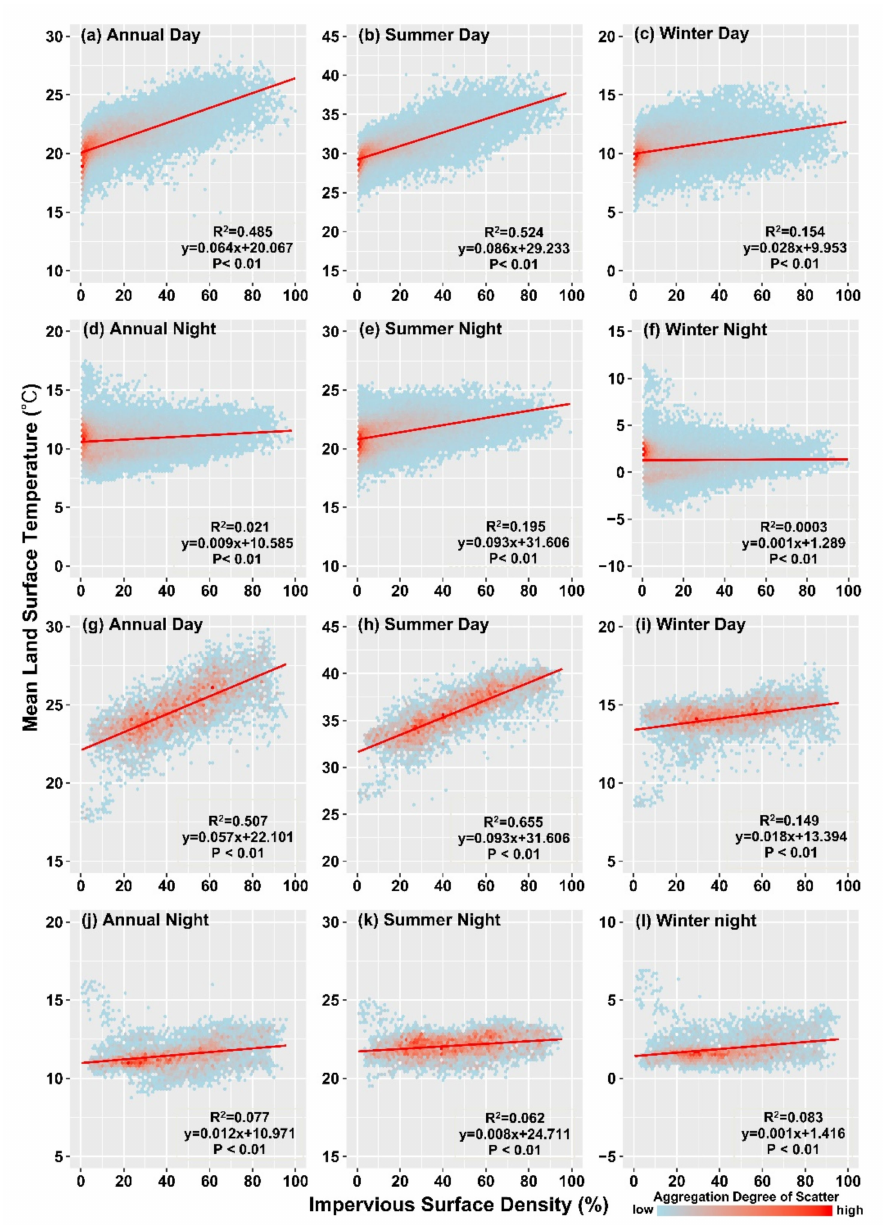
Figure 9. Relations between the density of the impervious surface area and the LST across the YRD. ( a – f ): Relations between the density of the impervious surface area and respectively the annual daytime LST, summer daytime LST, winter daytime LST, annual nighttime LST, summer nighttime LST, and winter nighttime LST across the YRD; ( g – l ): relations between the density of the impervious surface area and respectively the annual daytime LST, summer daytime LST, winter daytime LST, annual nighttime LST, summer nighttime LST and winter nighttime LST across the Shanghai city. Red line shows linear trends for the entire